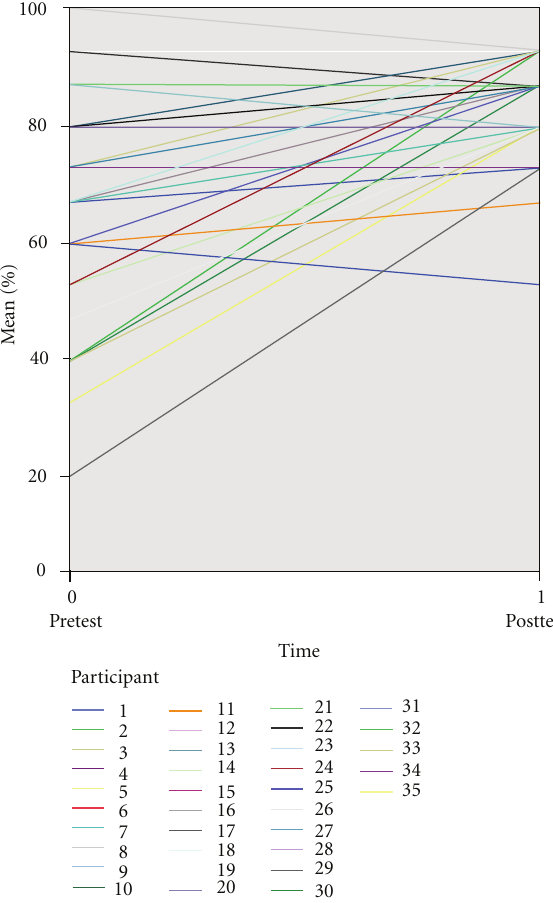
Figure 3: Before and after test